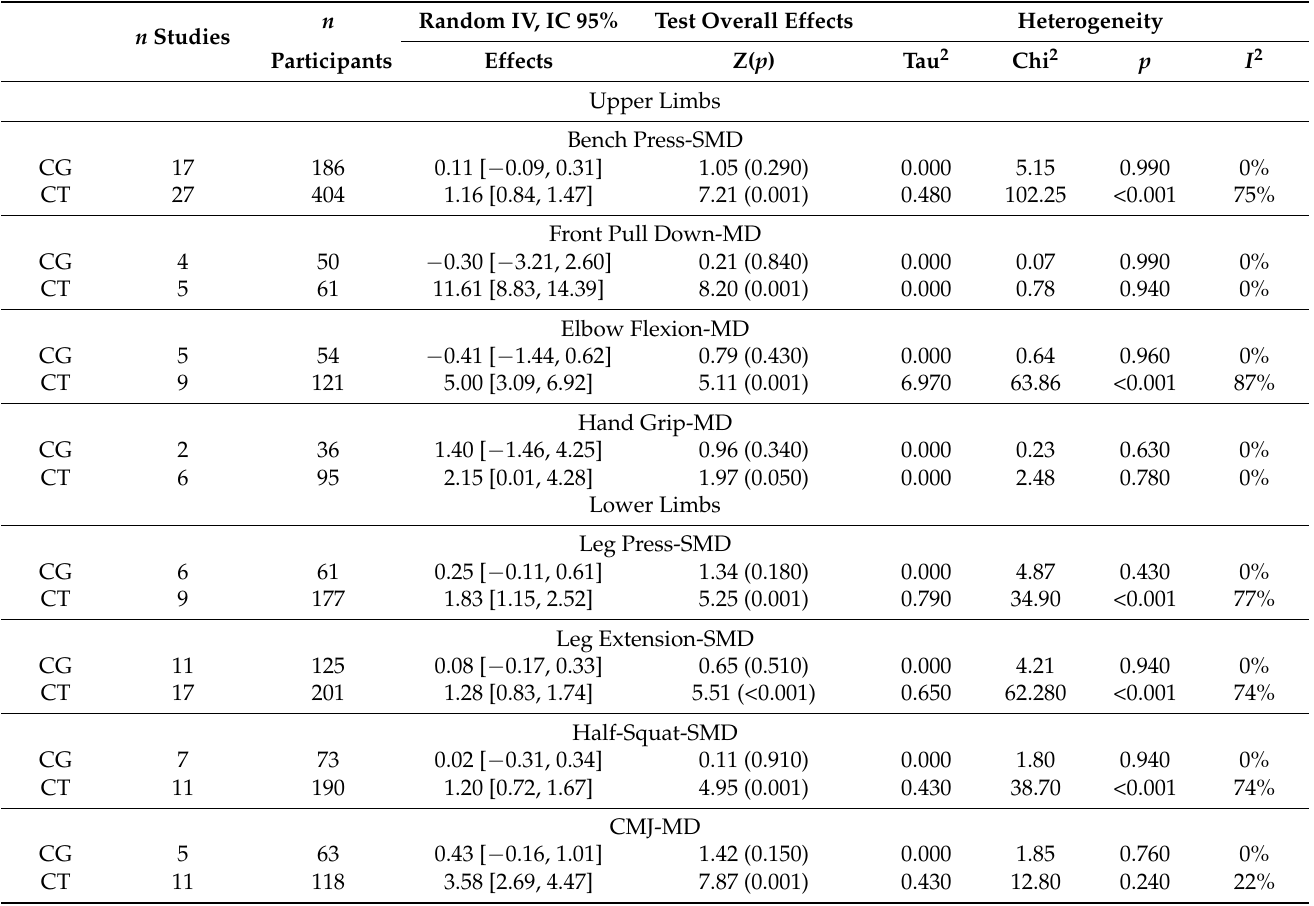
Table 4. Effect of circuit resistance training and endurance training on strength